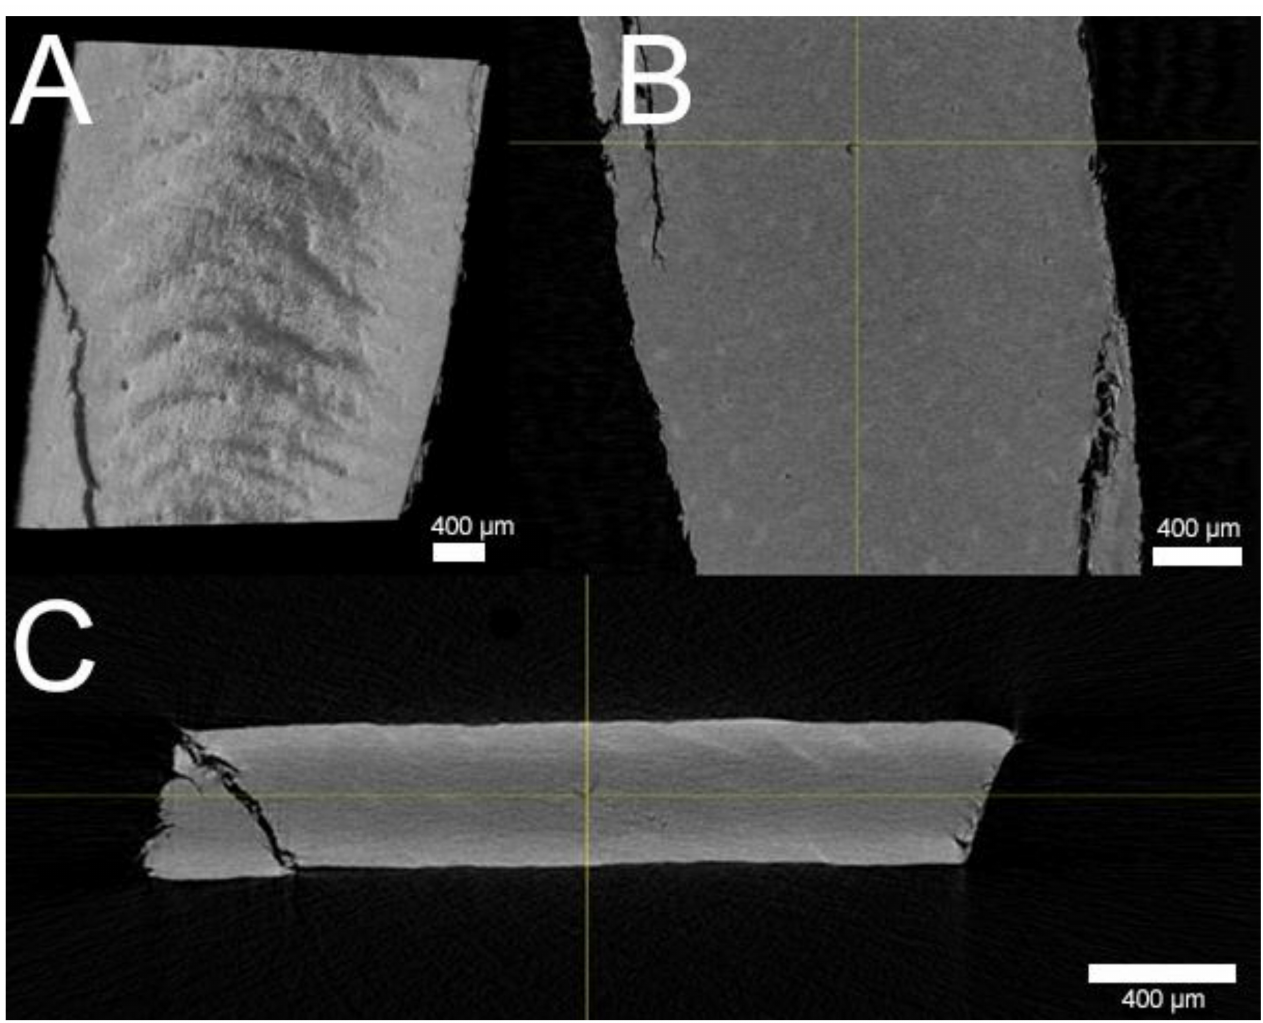
Figure 1. Scanning electron microscopy images of a bovine hoof sheet surface: ( A ) porous structures spread over the entire surface and ( B ) exemplarily focused ion beam milling of a pore reveals continuation into the membrane matrix.